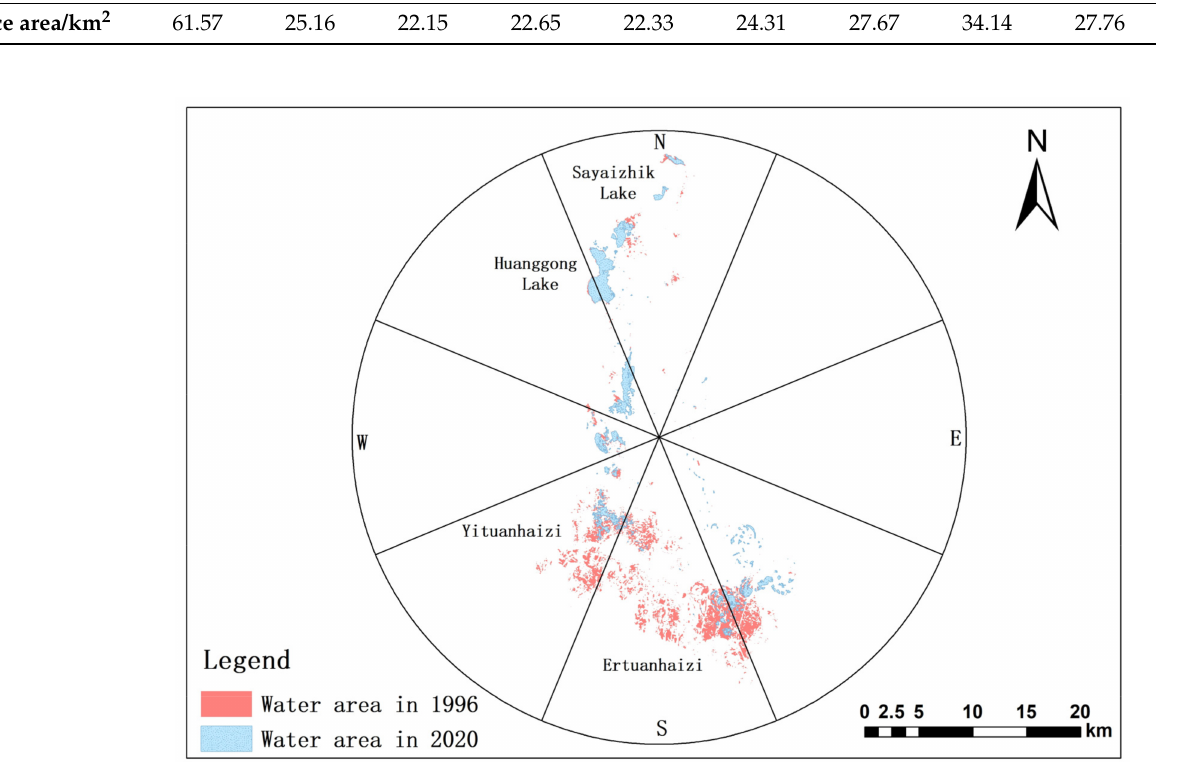
Figure 2. Schematic diagram of the spatial distribution of changes in the water surface area of Eichmann Lake.